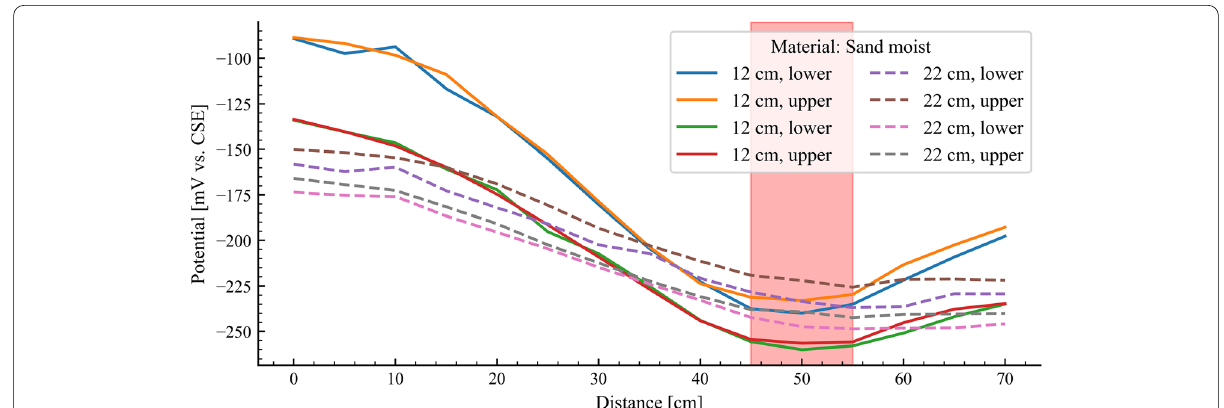
Fig. 10 Comparison of the potential measurement results in moist sand with varying distances between the RE and the reinforcement made of steel for the upper and lower row of holes in the wooden frame (see Fig. 11), where the red rectangle marks the location treated with sodium chloride during the casting of the block